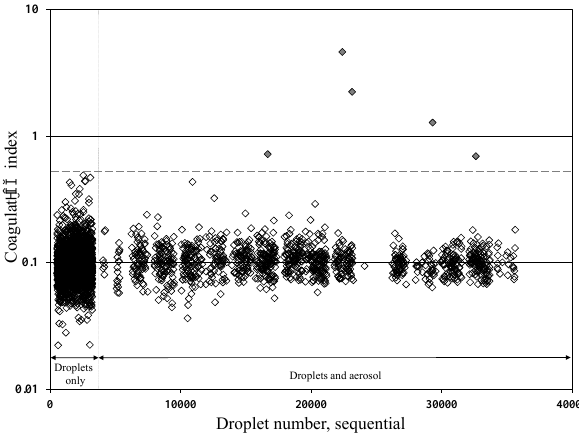
Figure 4. Coagulation index (CI), the ratio of PSL (aerosol) to AS (droplet residual) signal in a mass spectrum, for a typical exper- iment. In this experiment the RH was 15%, droplet radius was 20µm, and PSL particles were 0.125µm radius with a concentra- tion of 100cm − 3 . The x axis represents the sequential analysis of single droplet residuals over the course of the experiment. Parti- cles which exceed the ratio found when only droplets are analyzed (dashed line; the “droplets only” data acquired at the start of each experiment) are considered collection events. There are five collec- tion events during this experimental